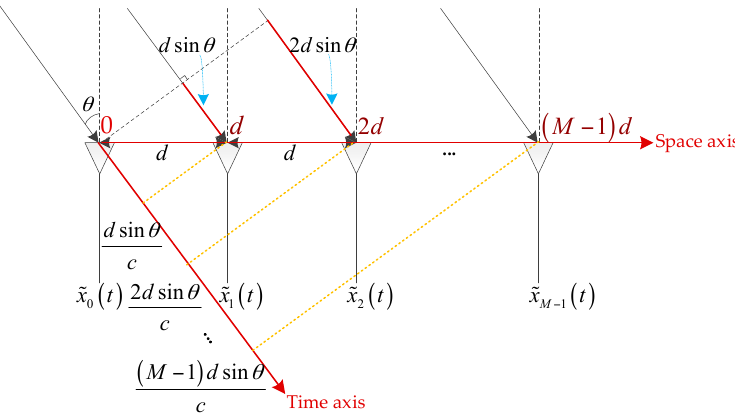
Figure 1. Geometric diagram of the relationship between the direction of arrival and array structure.